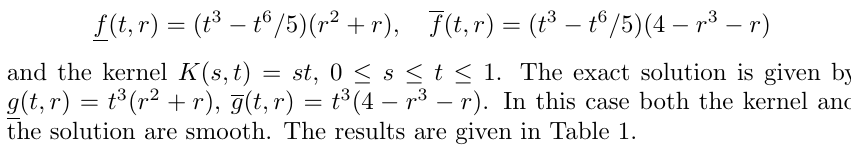
Table 1. Comparison of numerical results for Example 1. N error (triang.) ratio error (rectang.) ratio error at τ k ratio